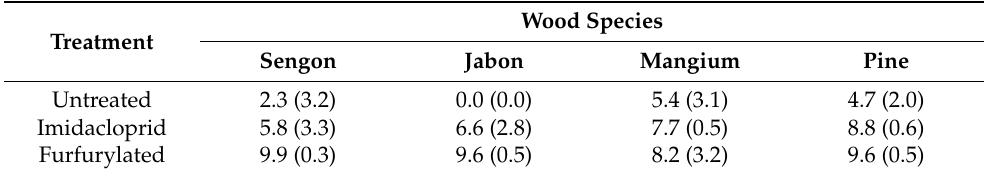
Table 13. Protection level of specimens.